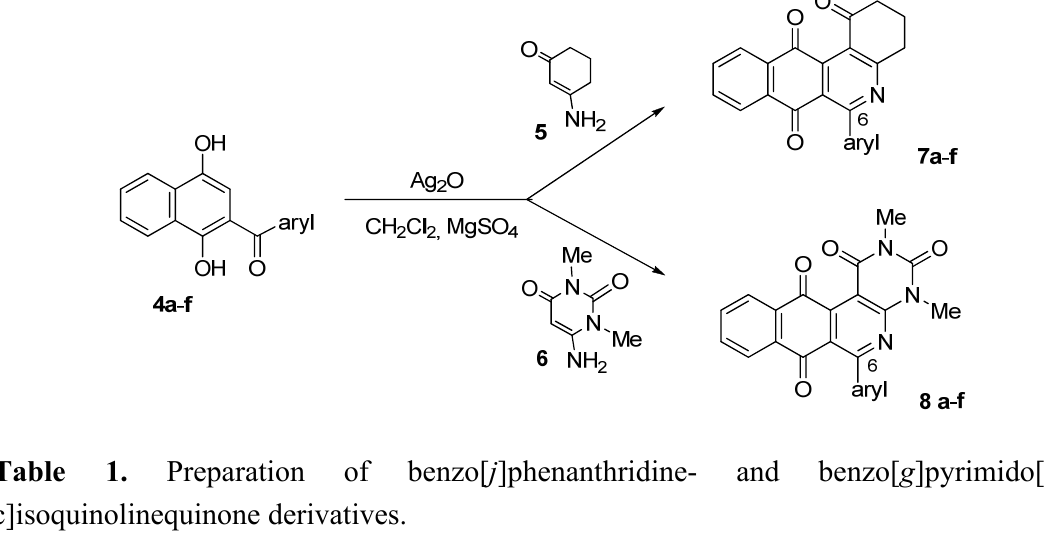
Scheme 2. Synthesis of 6-substituted angular quinones 7 and 8 .